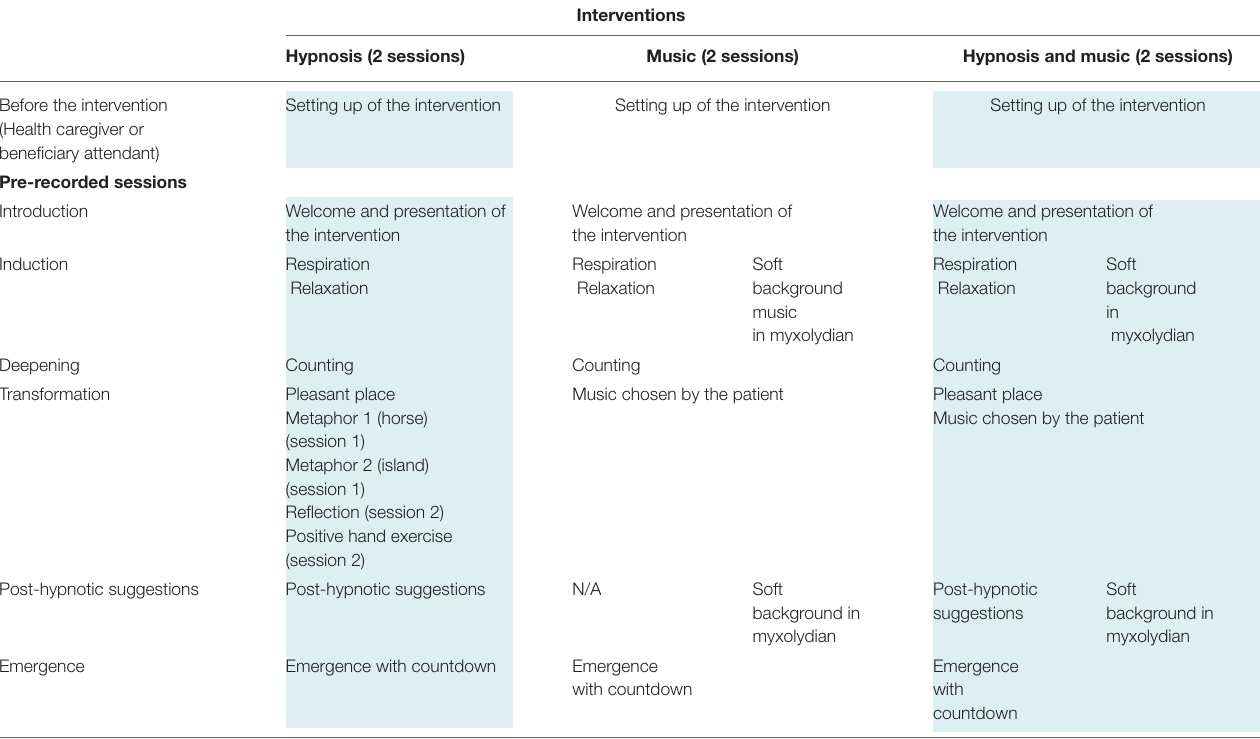
TABLE 1 | Structure of the MuzHyp © intervention program (version